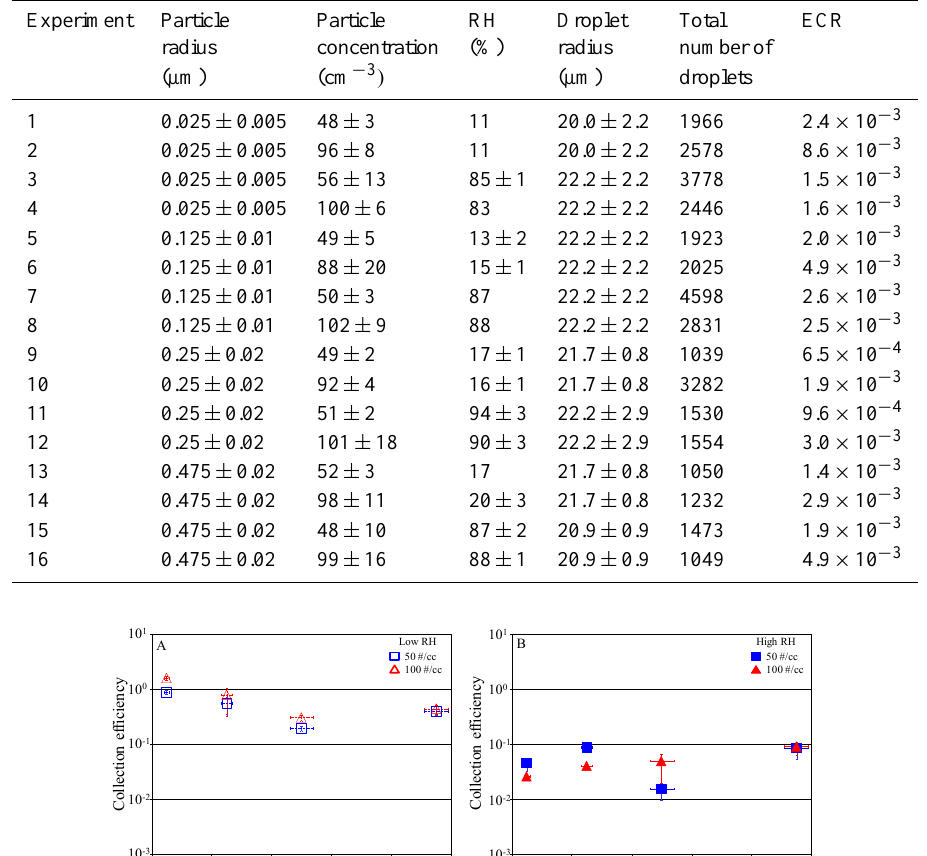
Table 3. Particle size and concentration, RH, droplet size and total analyzed and experimental collection ratio (ECR; see text for details) for this study.